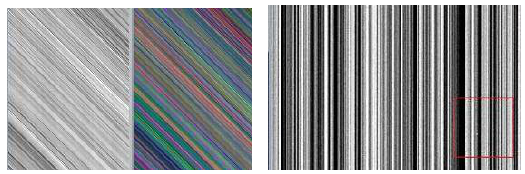
Figure 7 : examples of AMETHIST PAN, XS and slow-Motion